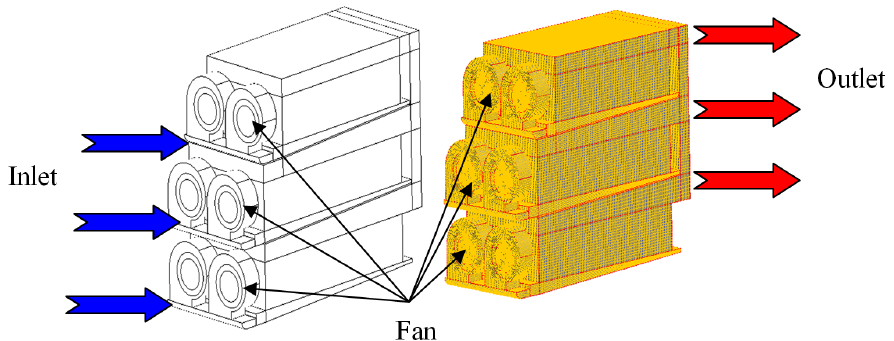
Figure 9. CFD simulation model of the primitive pack.